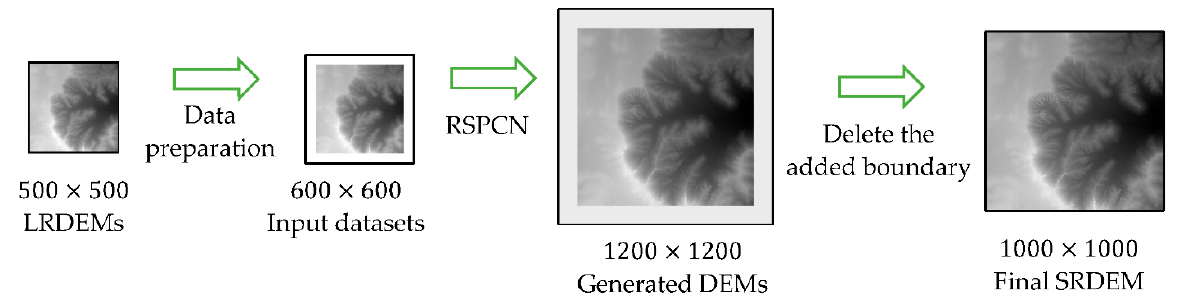
Figure 10. The process of “adding-zero”: adding “zero” to the boundary of the 500 × 500 LRDEMs to build 600 × 600 input datasets before the RSPCN network; deleting the “zero” boundary of the 1200 × 1200 generated DEMs to obtain the final 1000 × 1000 SRDEMs. For visualization, the black outlines show the picture boundary.